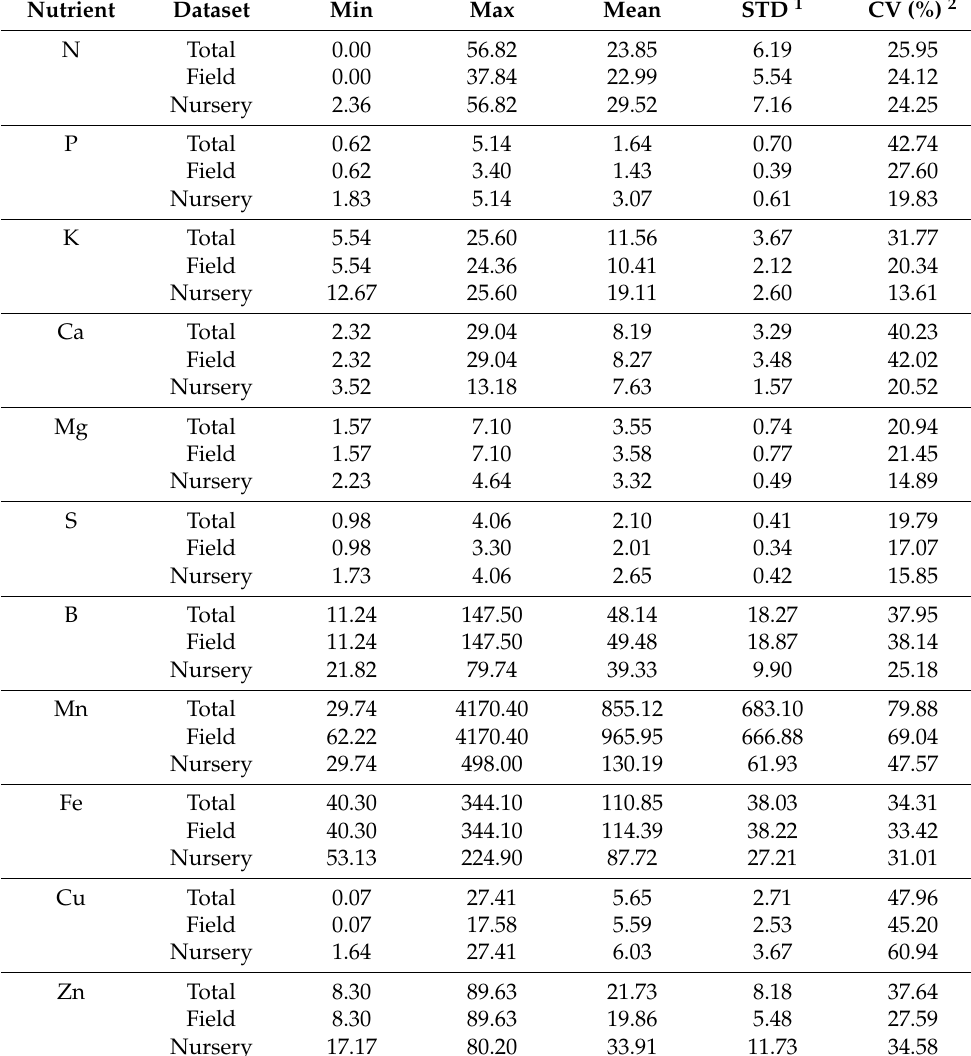
Table 1. Descriptive statistics of macro (g kg − 1 ) and micronutrients (mg kg − 1 ) using conventional analysis of Eucalyptus spp. leaves for field and nursery plants, separately and combined (total